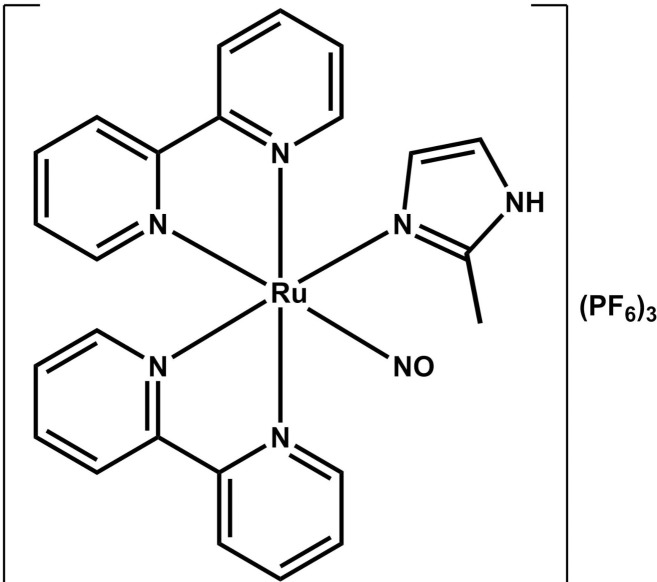
Chemical structure of the ruthenium complex cis-[Ru(bpy)2(2-MIM)(NO)](PF6)3.